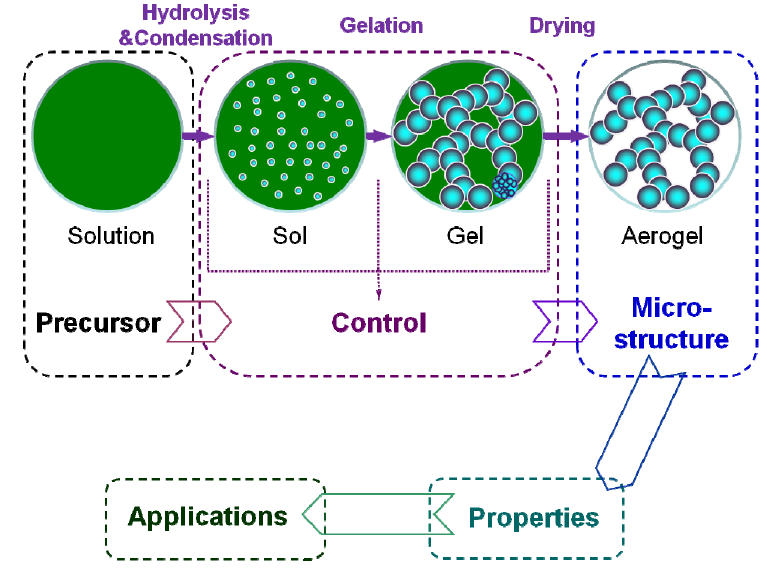
Figure 4. Basic research scheme for the